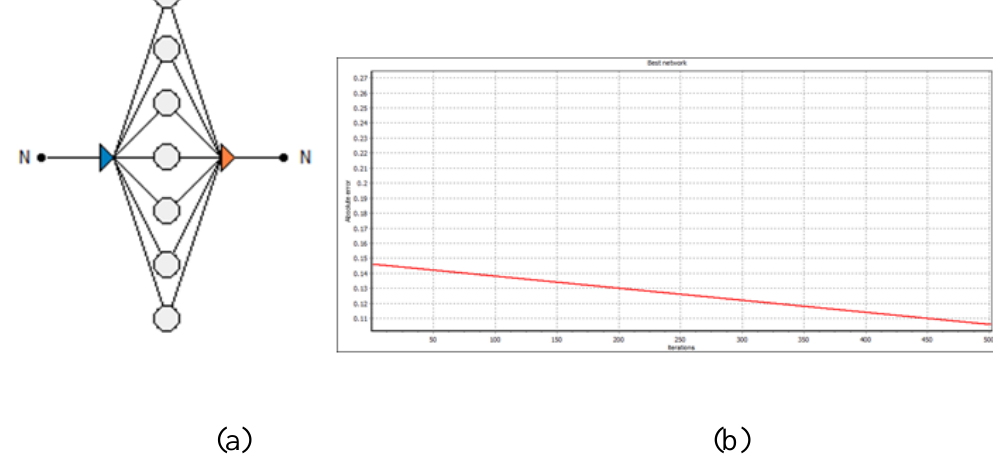
FIG.8 Fig. 8. The selected neural network consisting of 7 hidden layers (a) and the corresponding convergence curve (b) .